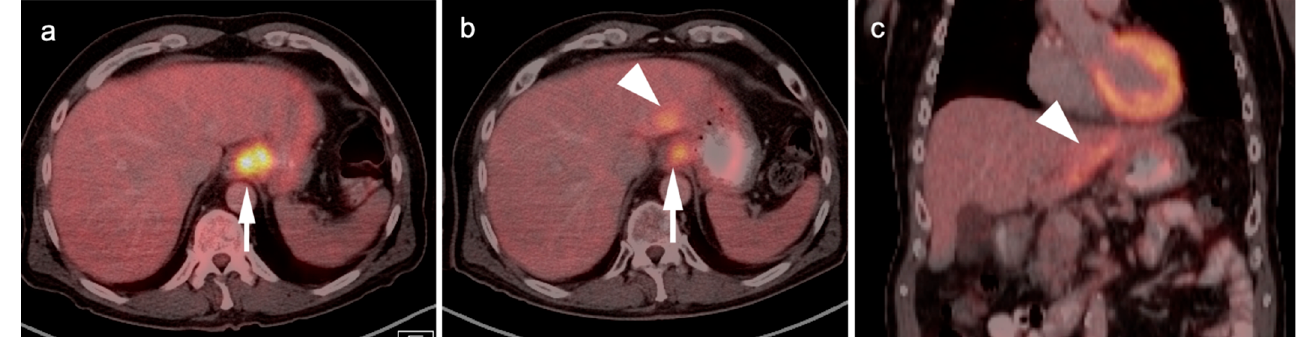
Figure 3. Esophageal cancer pre- and post-treatment. ( a ) Pre-treatment axial fused FDG PET-CT image shows a circumferential hypermetabolic esophageal tumor (white arrow); ( b , c ) Axial ( b ) and coronal fused FDG PET-CT images five weeks post-neoadjuvant CRT demonstrate residual soft tissue thickening and metabolic activity (white arrow), although improved from pre-treatment. This would require biopsy to distinguish residual viable tumor from post-treatment inflammatory change. In addition, there is increased metabolic activity along the left border of the liver (white arrowhead) likely due to the liver being within the radiation field.